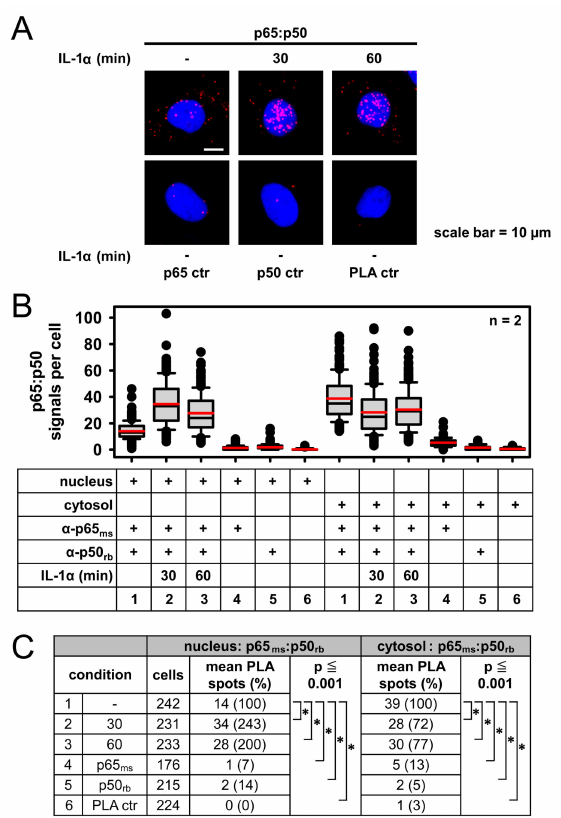
Figure 5. PLA-based analysis of IL-1 α -induced translocation of p65 / p50 heterodimers to study NF- κ B functions in the nucleus. ( A ) HeLa cells were left untreated or stimulated with IL-1 α (10 ng / mL) as shown. Cells were permeabilized using an adapted PLA protocol to increase the access of antibodies to the nuclear fraction, followed by PLAs using antibodies recognizing p50 and p65, respectively. Representative cells are displayed: Nuclei were visualized by Hoechst 33342 staining. ( B , C ) PLA data of cells from two independent experiments were pooled. Evaluation and statistical analyses were performed as described for Figure 1. Distribution of PLA signals is shown in ( B ) and the summary and statistics of all relevant data are depicted in ( C